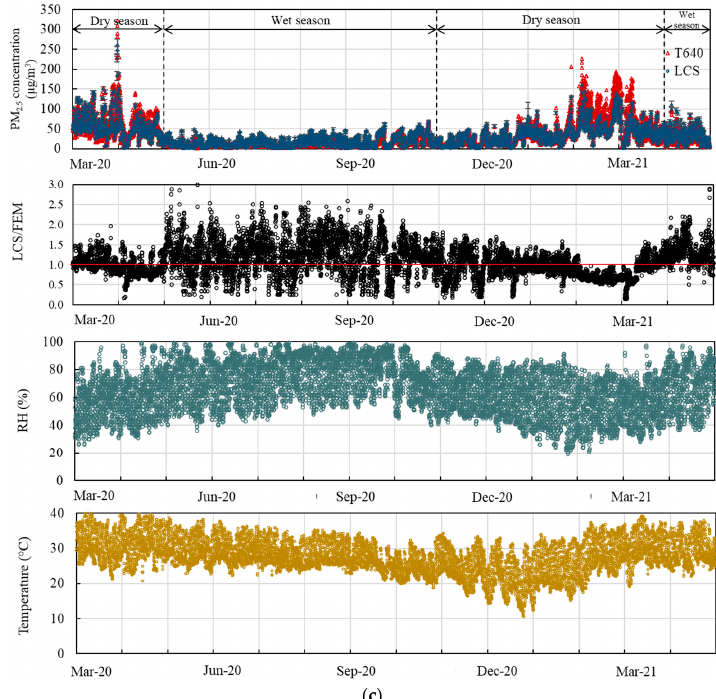
Figure 3. Time series of 1-h PM 2.5 concentrations from LCS and FEM; ratio of LCS to FEM, RH and temperature at ( a ) CM, ( b ) BKK and ( c ) URT: the red line indicates the ratio LCS/FEM = 1.